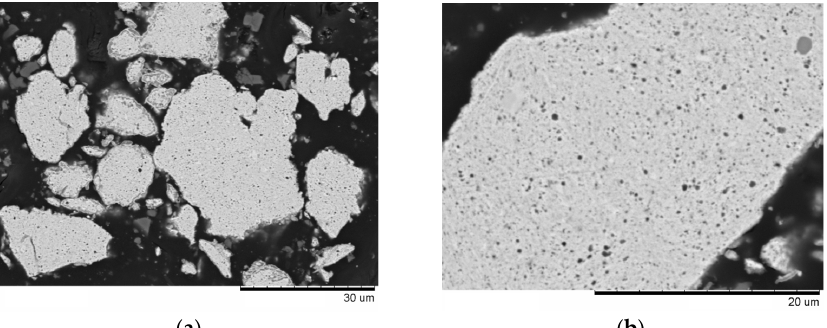
Figure 5. Thermograms of thermal explosion (TE) in HEBM Ti-C (carbon black)-3Cu mixtures. Milling time is given next to the curves. Reprinted from [38], Copyright (2021), with permission from Elsevier.